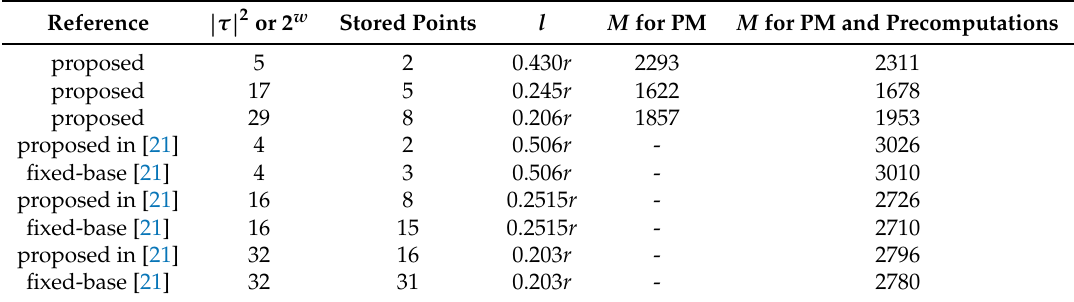
Table 1. Performance results for different τ -adic expansions in comparison with [21] for a binary key length r = 163 according to